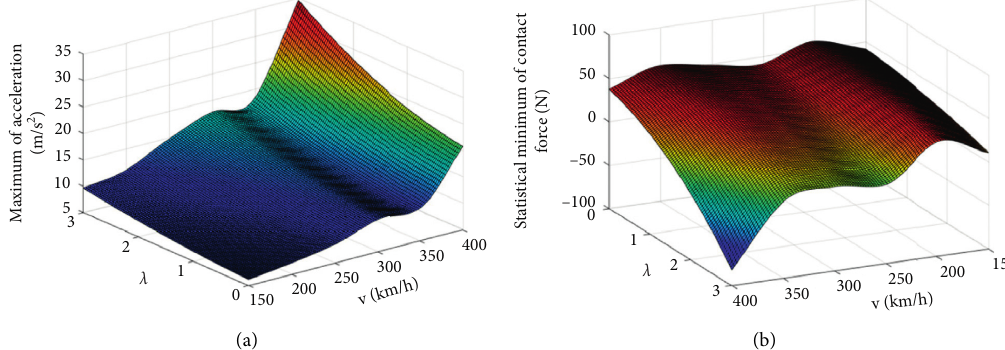
Figure 12: The influence of ice thickness on the current collection quality under different operating speeds (increased density method). (a). Maximum of acceleration; (b) statistical minimum of contact force.